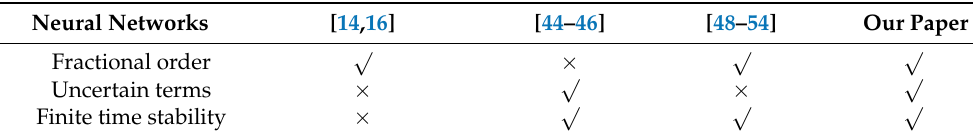
Table 1. Comparison with other